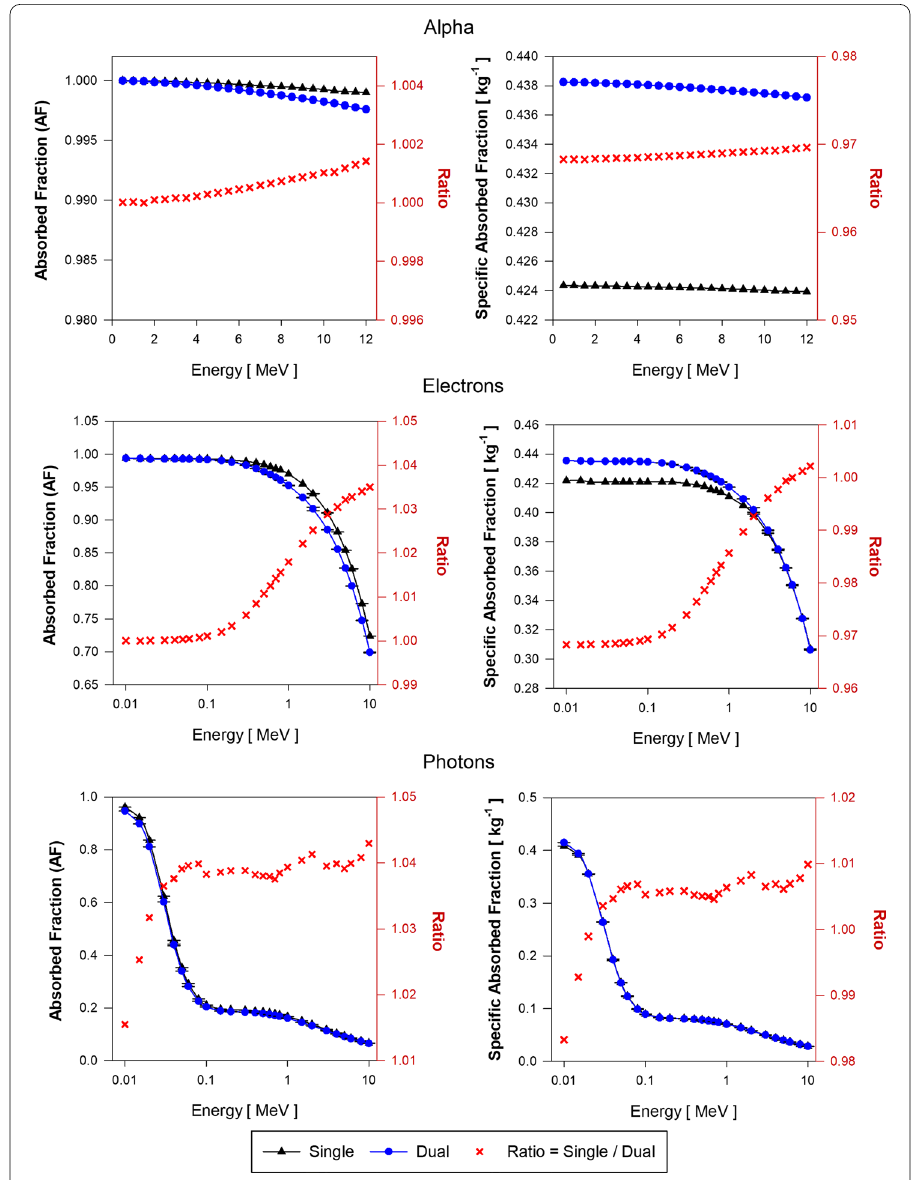
Fig. 10 Approximations of AF ( LP ← LP ) and SAF ( LP ← LP ) for monoenergetic alpha particles (Top), electrons (Center), and photons (Bottom) using the single‑region liver model (black triangles) and the dual‑region liver model (blue circles) in tetrahedral mesh‑type format for the reference adult male liver